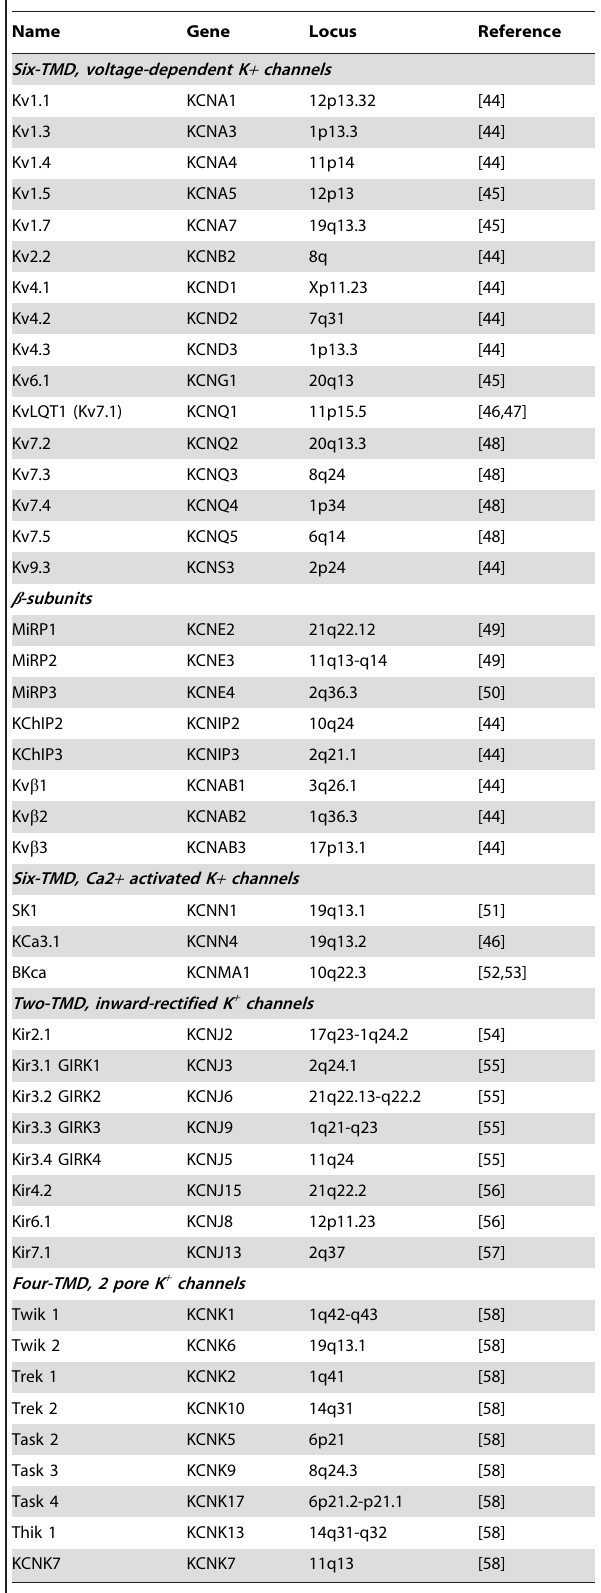
Table 2. List of analyzed potassium